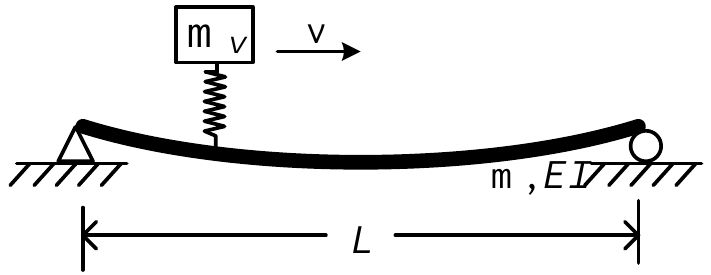
Figure 1. Simply supported beam traversed by a moving vehicle.